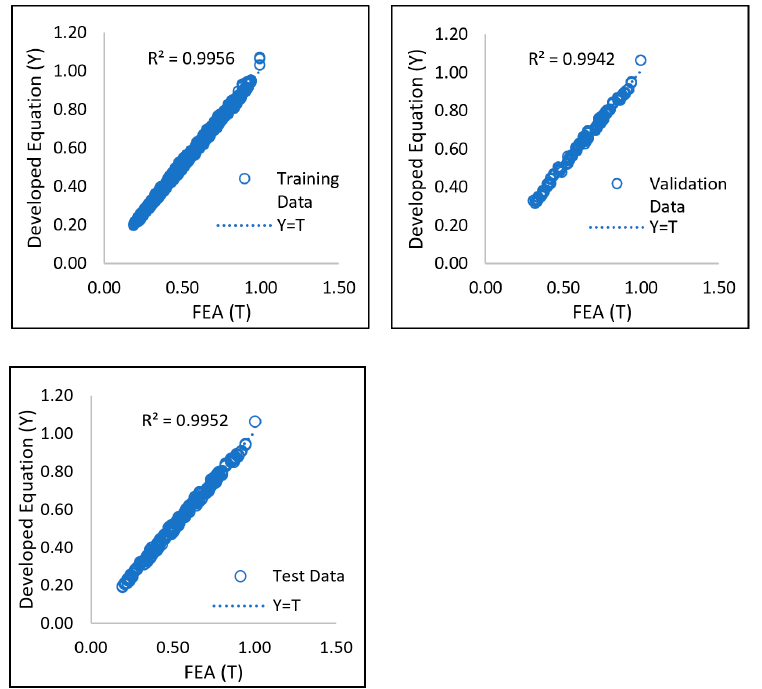
Figure 5. Regression plot of the developed ANN for training, validation, and test phases.